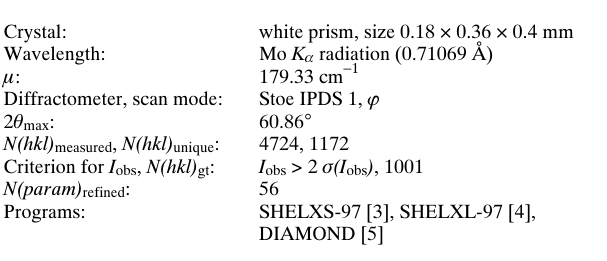
Table 1. Data collection and handling.